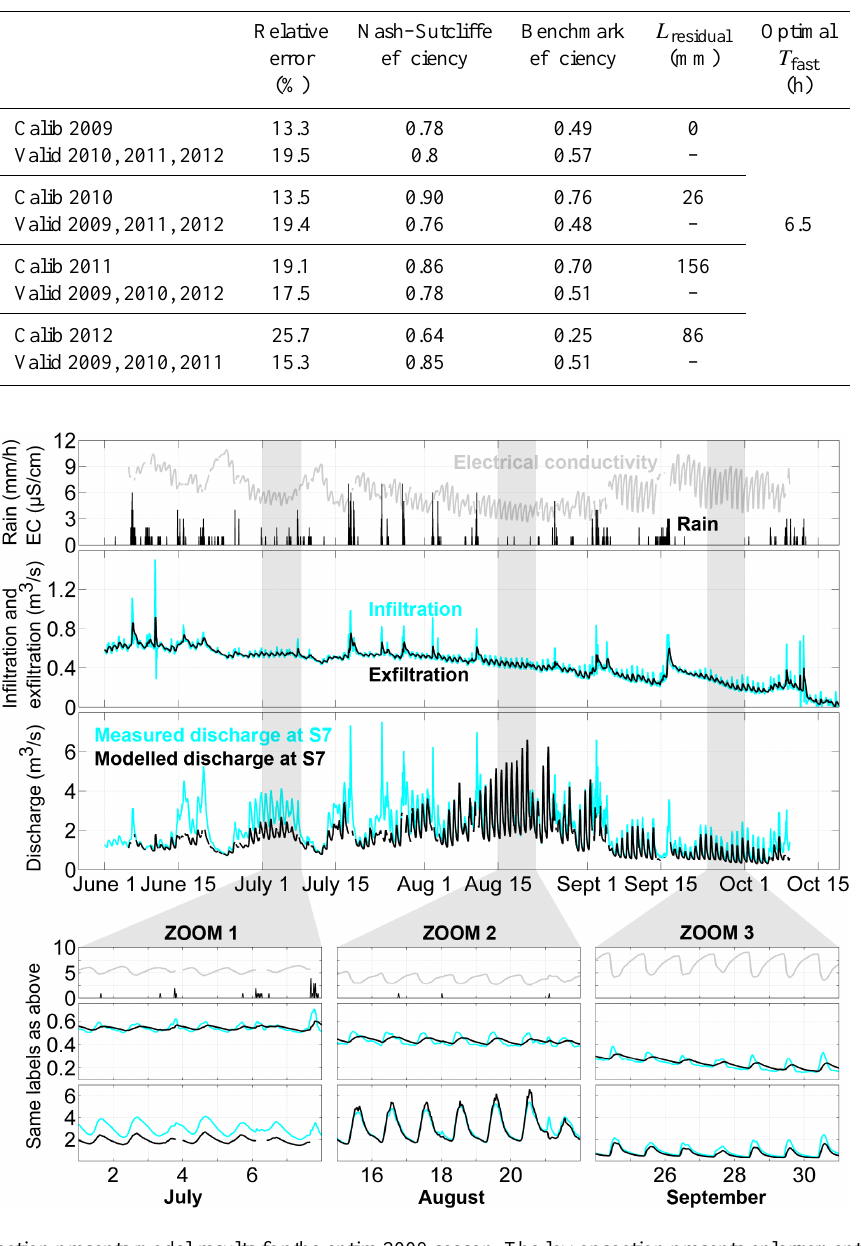
Table 4. Calibration and validation results for the FULL model after adjusting for L residual .